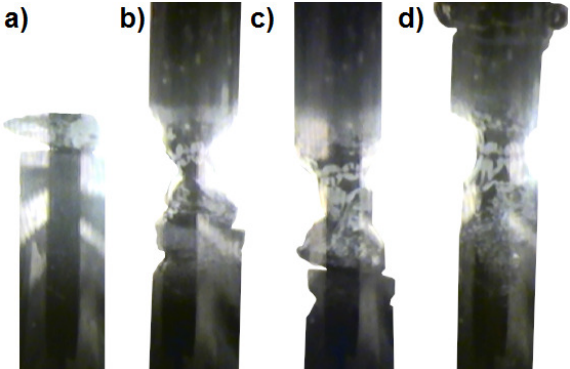
Figure 3. Images of the floating zone growth, with ( a ) showing the glued crystal seed on the top of the seed rod, ( b ) the start of the growth, and ( c , d ) the evolution after several hours of growing.